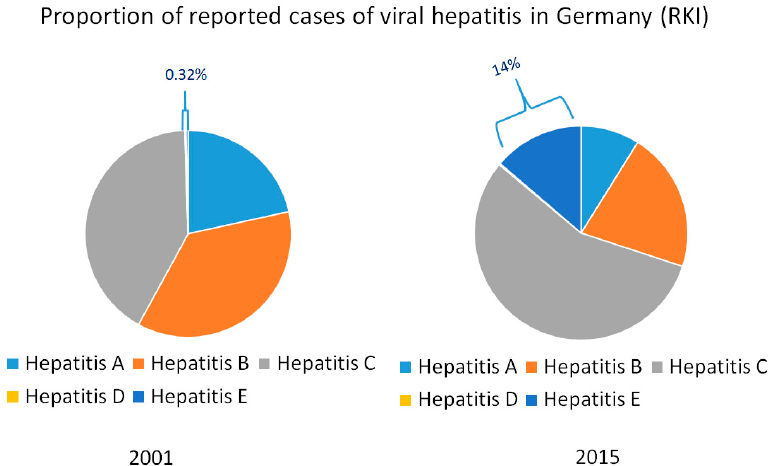
Figure 2. Proportion of diagnosed cases of hepatitis A–E in Germany basing on data from the Robert ‐ Koch ‐ Institute (RKI).